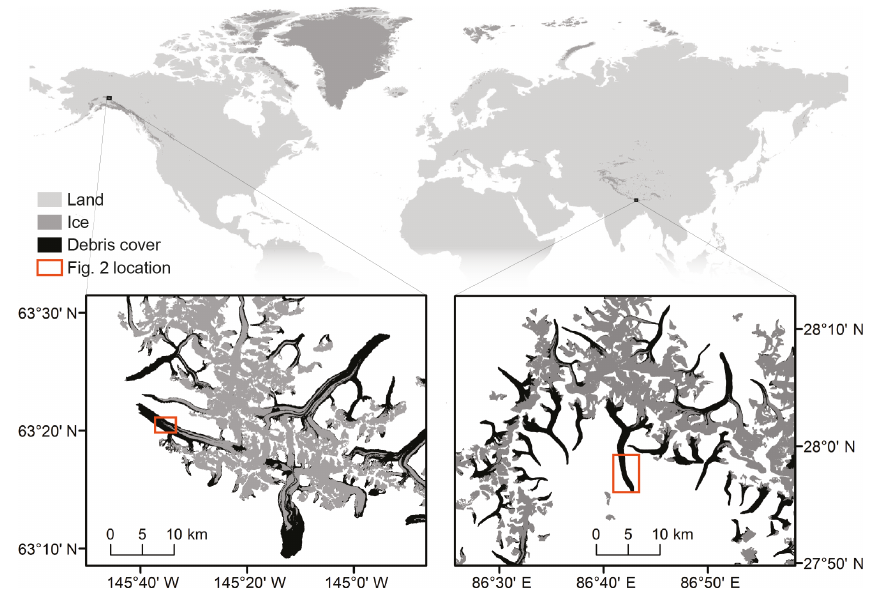
Figure 1. Location of Canwell Glacier in the eastern Alaska Range, Alaska, USA, and Ngozumpa Glacier in the Khumbu Himal, Nepal. Ice area is from Pfeffer et al. (2014) and Citterio and Ahlstrøm (2013). Scale and area shown in the two inset plots are the